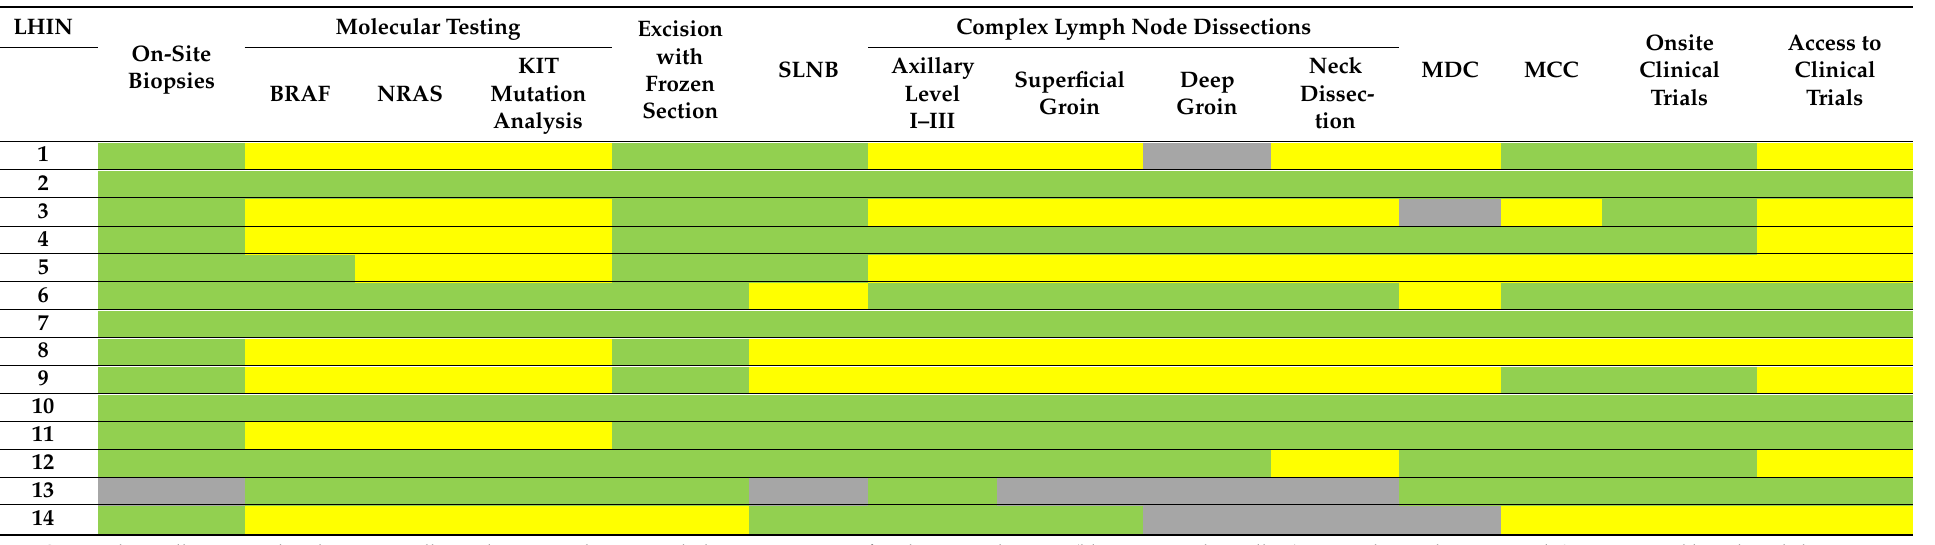
Table A2. Access to initial diagnosis and diagnosis services for skin cancer care in Ontario by Local Health Integration Network (LHIN).